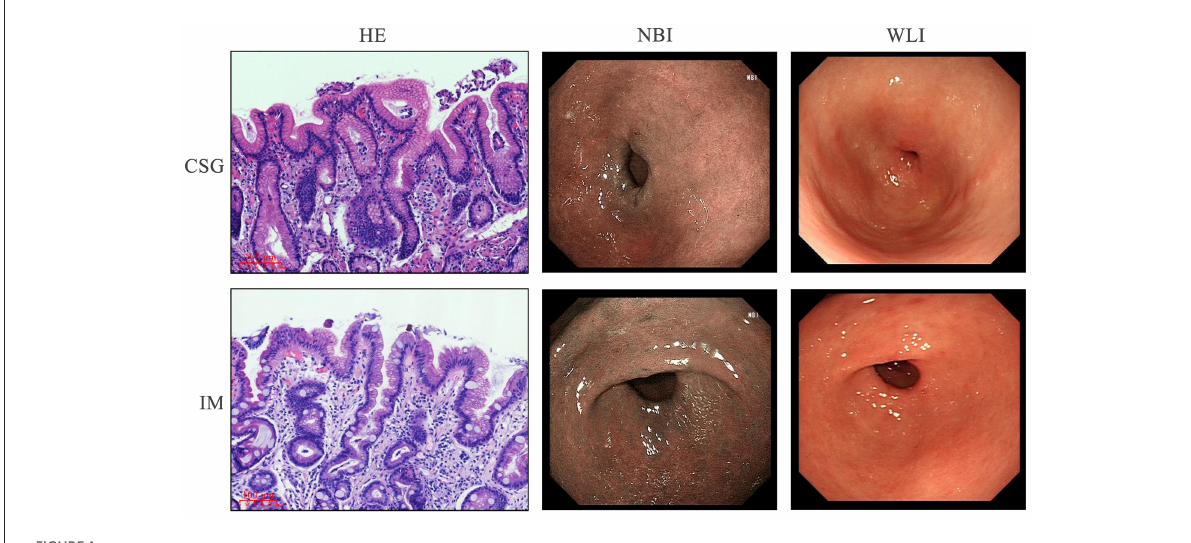
FIGURE1 Gastroscopy and histological staining in patients with CSG and IM.